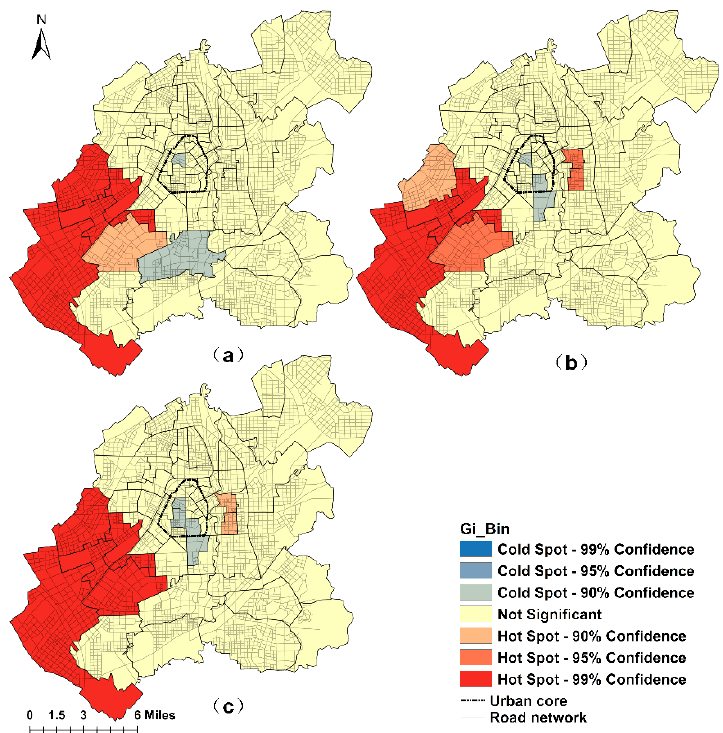
Figure 6. Spatial patterns of SE i in di ff erent scenarios. ( a ) 5-min scenario; ( b ) 10-min scenario; ( c ) 15-min scenario.